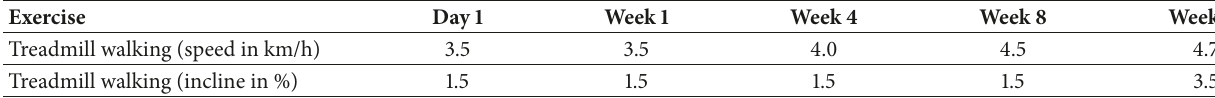
Table 2: Increase in training workload in patient 2.